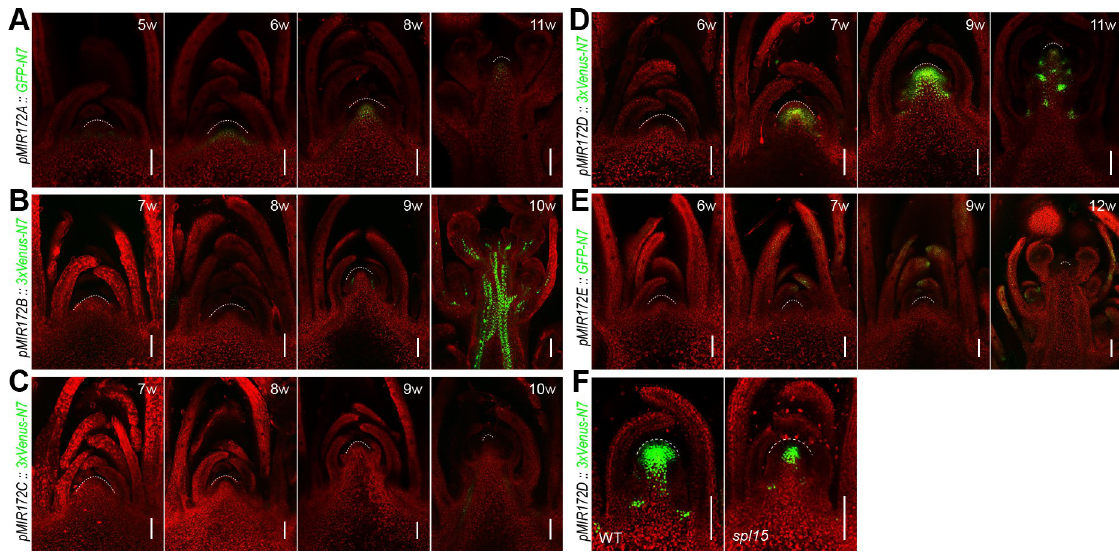
Fig 6. Expression pattern of MIR172 genes in short days. (A–E) Analyses of MIR172 reporters. Plants were grown at 22˚C in short days. The shoot apices were examined. Please note that the plants start to flower after 10 weeks. Over 20 T 1 independent lines for each reporter were examined, and the results of 1 representative T 2 line are shown. Dash line marks the SAM. Scale bars represent 100 μ m. (F) Expression of MIR172D reporter in WT and the spl15 mutant. Dash line marks the SAM. Scale bars represent 100 μ m. The same confocal settings were used for scanning for each reporter line. SAM, shoot apical meristem; WT, wild